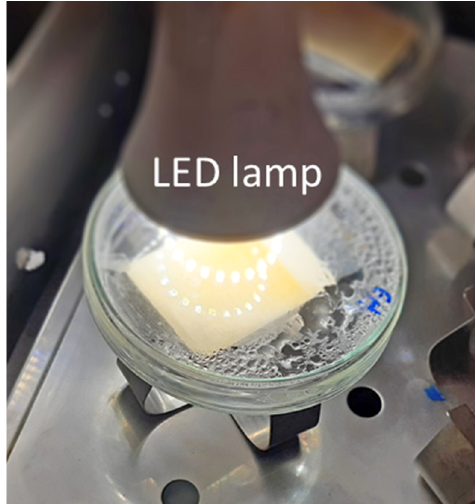
Figure 1. Experimental setup for Cr(VI) photocatalytic reduction with immobilized Ce–ZrO 2